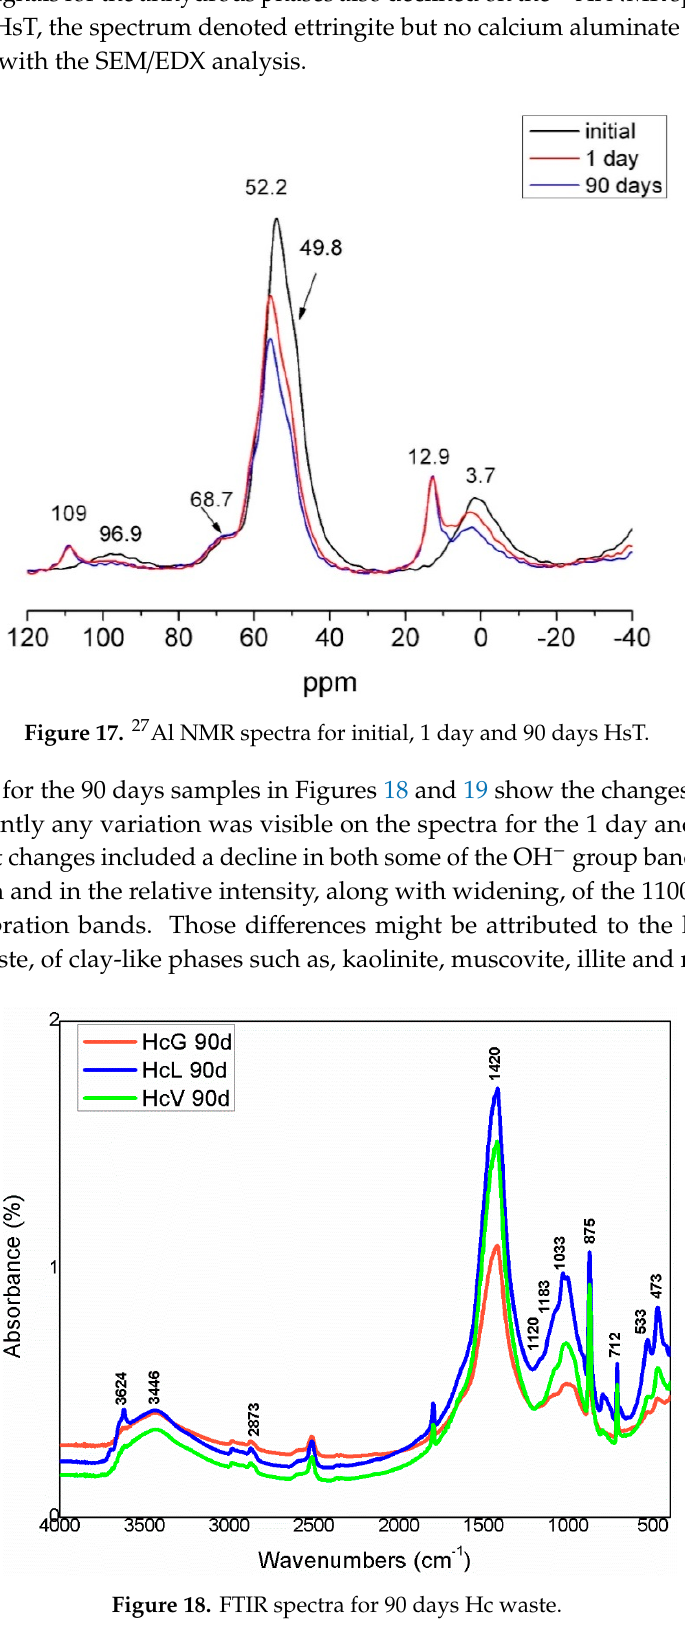
Figure 16. 27 Al NMR spectra for initial, 1 day and 90 days HcG.